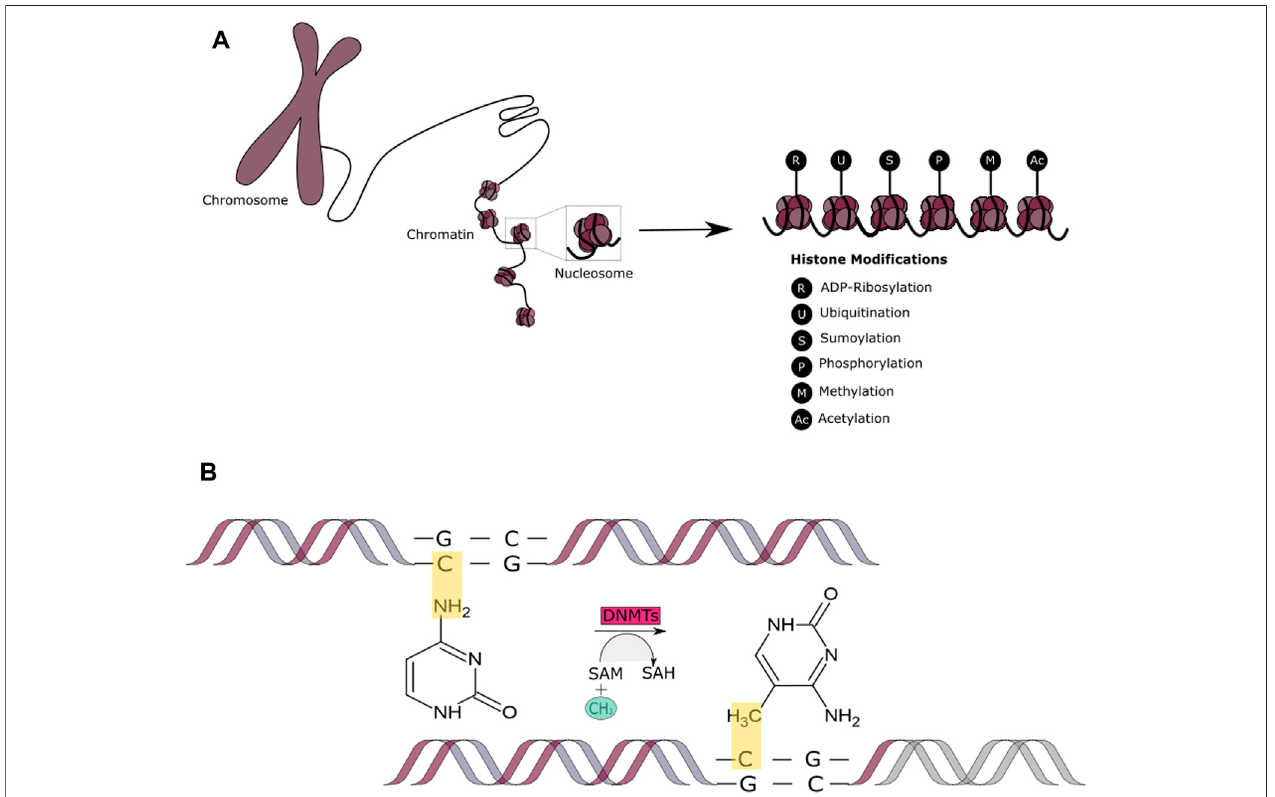
FIGURE 3 | Epigenetic Mechanisms - Histone Modi fi cations and DNA methylation. (A) A schematic representation of the covalent post-translational modi fi cations to histone proteins. These include ADP-ribosylation, ubiquitination, sumoylation, methylation, acetylation, and phosphorylation. (B) A schematic representation of the DNA methylation process that occurs by addition of the methyl (CH 3 ) group to the DNA, thereby often modifying the function of certain genes and affecting gene